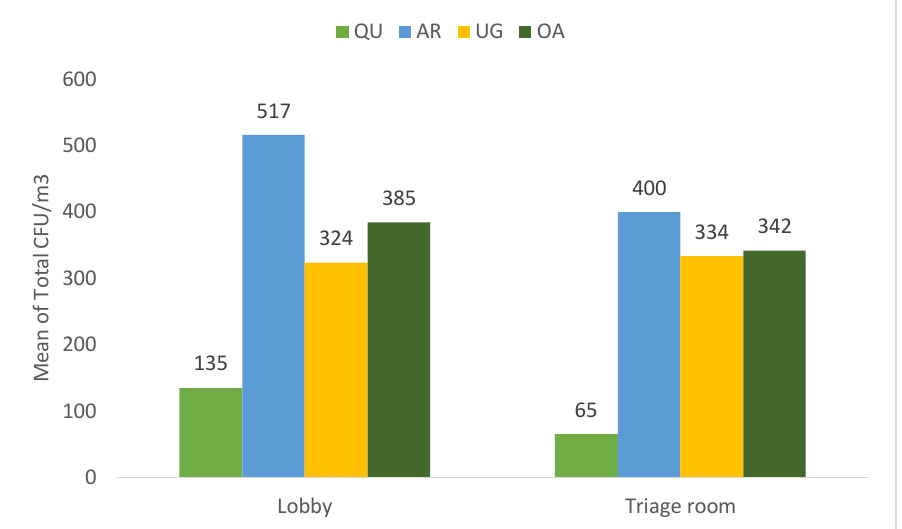
Figure 5. The total mean airborne concentration of indoor areas (lobby and triage room) at all health centers.